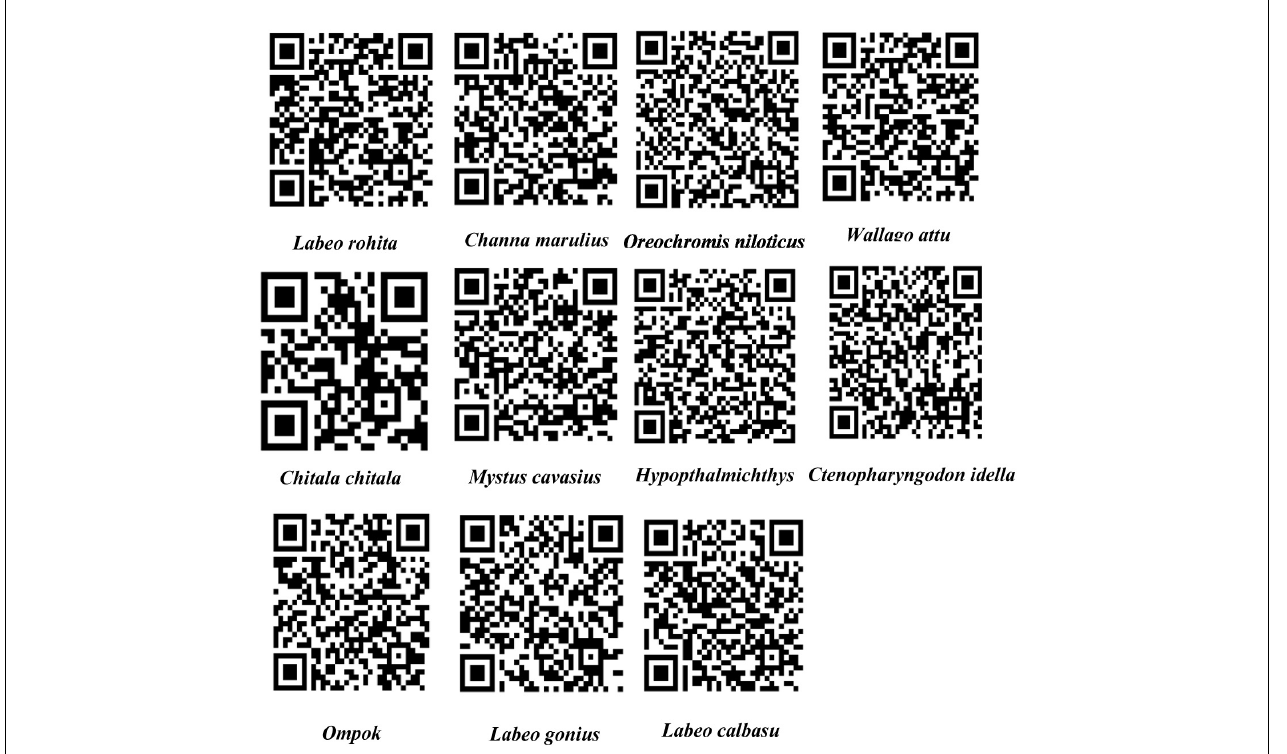
FIGURE 5 | QR codes generated using unique single nucleotide polymorphism data for freshwater fish species.